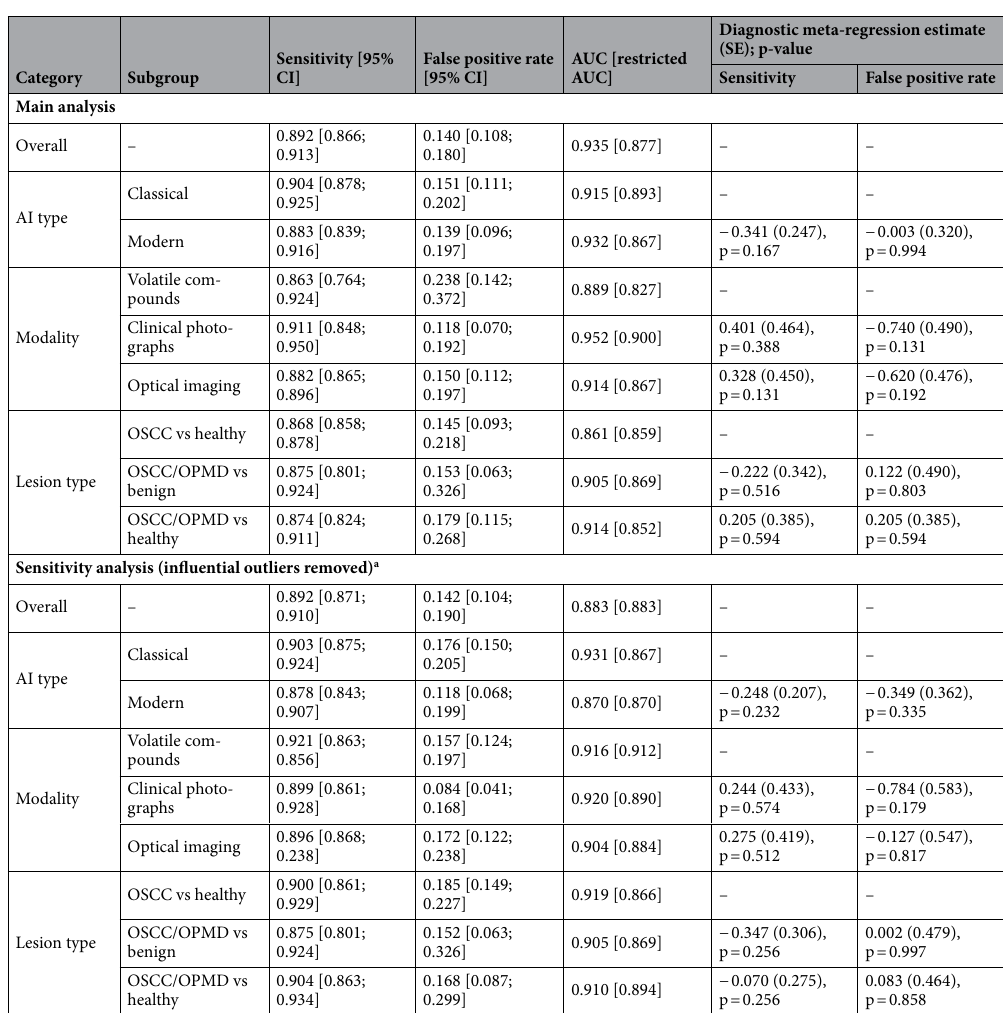
Table 4. Results of main bivariate random effects model of diagnostic test performance, subgroup analysis, and sensitivity analysis following removal of influential outliers. a Influential studies removed for sensitivity analysis 2,20,25,26,30,33,38,43,46